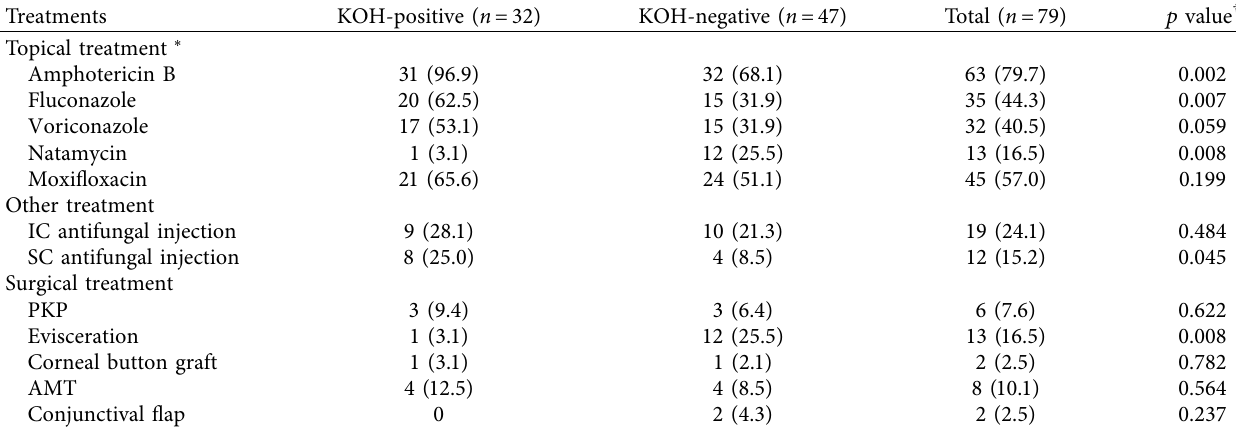
Table 6: Medical and surgical treatment for eyes with culture-proven Fusarium keratitis divided by the initial KOH smear.